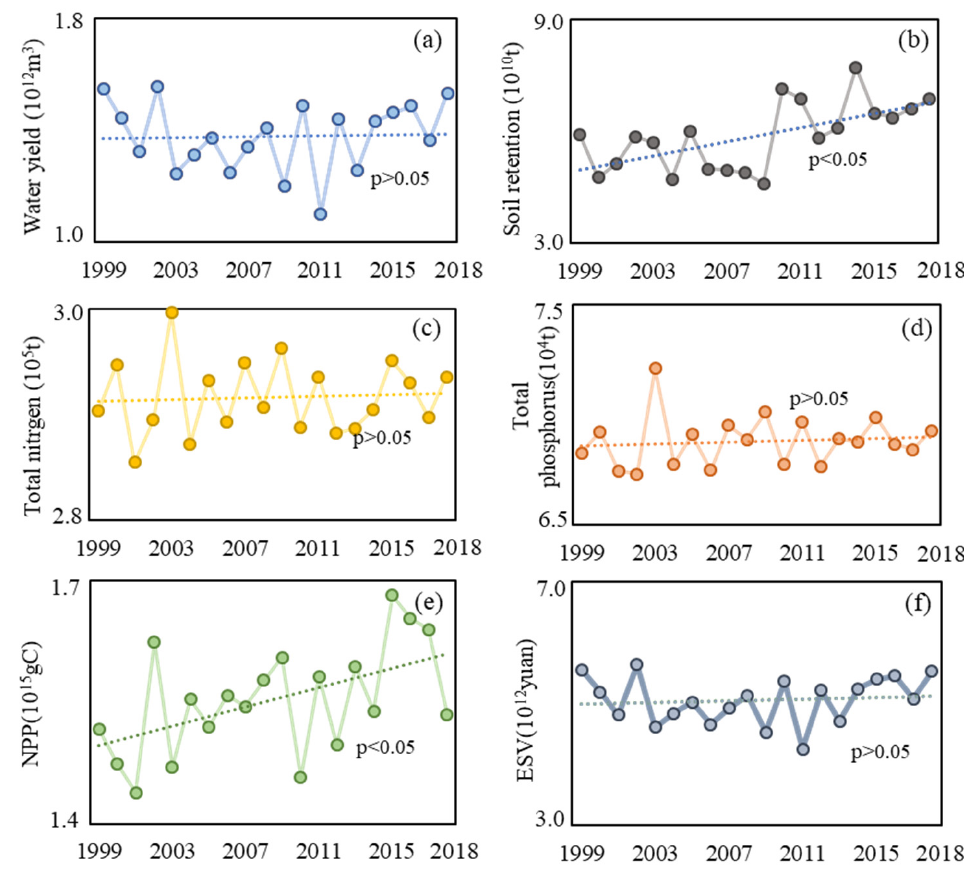
Figure 4. The changes of ESs in the YREB from 1999 to 2018 (( a ): water yield; ( b ): soil retention; ( c ): total nitrogen; ( d ): total phosphorus; ( e ): NPP; ( f ): integrated ESV).